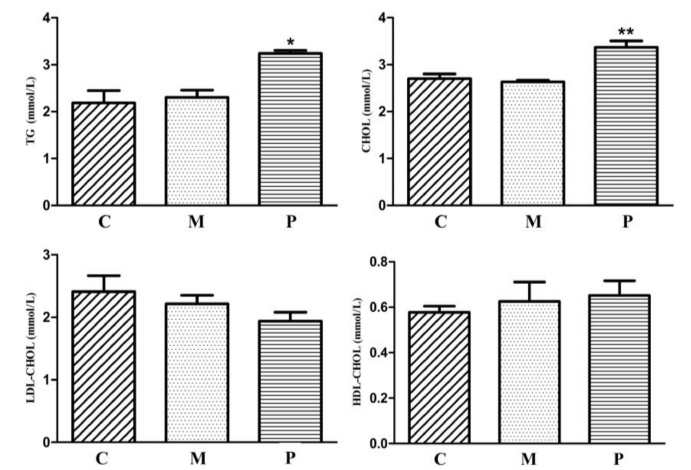
Figure 5. Serum lipid indices of all F1 JXH chickens in the control (C, n = 105), maternal (M, n = 80) and paternal (P, n = 82) groups. TG: triglyceride, CHOL: total cholesterol, LDL-CHOL: low-density lipoprotein, HDL-CHOL: high-density lipoprotein. * indicates p < 0.05 and ** indicates p < 0.01.